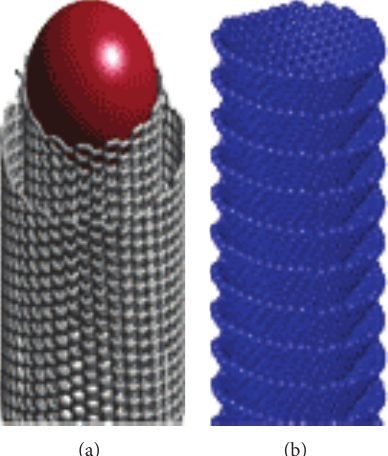
Figure 1: Schematic depiction of multiwalled carbon nanotube (a) and carbon nanofiber